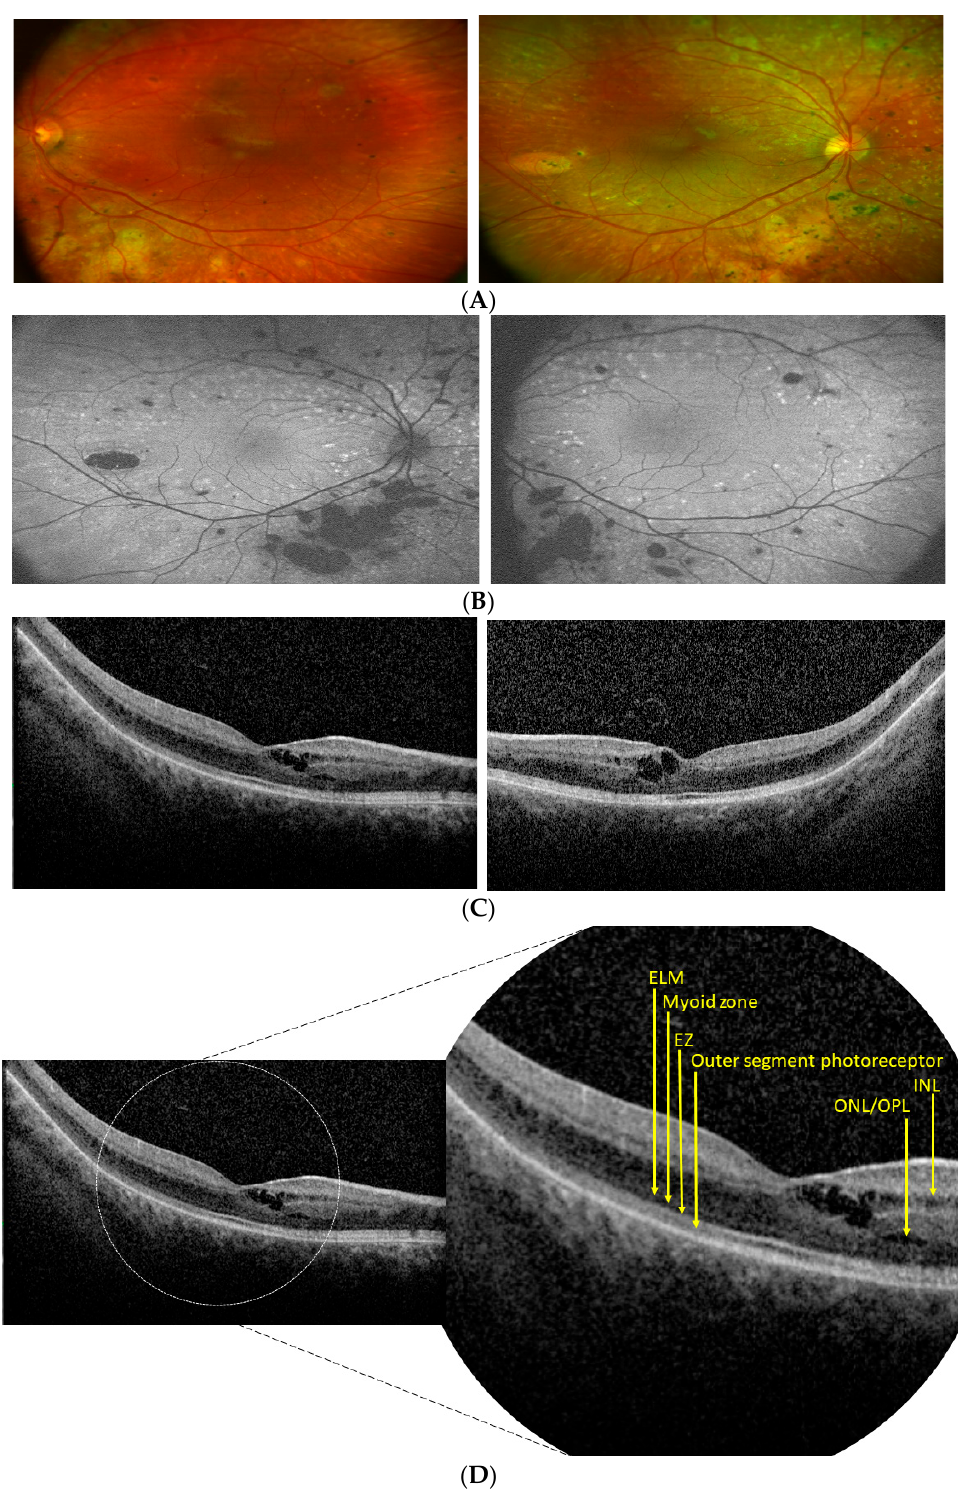
Figure 1. Retinal features of Patient 1: ( A ) Fundus images of the right and left eye showing areas of chorioretinal atrophy with yellowish dots and retinal pigment epithelium mottling at the posterior pole, more pronounced along the vascular arcades; ( B ) FAF images showing hypoautofluorescent patches corresponding to the atrophic lesions and hyperautofluorescent spots corresponding to the yellow dots; ( C ) HD SD-OCT macular B-scans showing a focal thickening of the fovea, associated with intraretinal lacunae of different sizes, greater in the central fovea and in the ONL and OPL. Microcysts are present in the INL. The contiguous ELM, the myoid zone, the EZ, and the outer segment photoreceptor layers are focally fragmented and present multiple areas of irregular optical